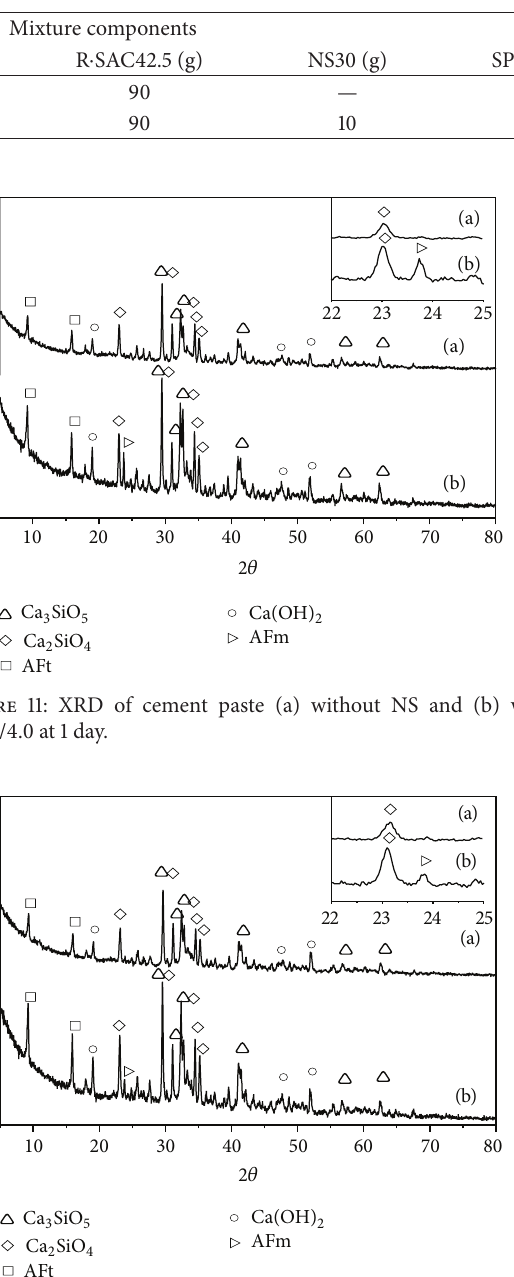
Table 5: Mix proportion of different pastes.